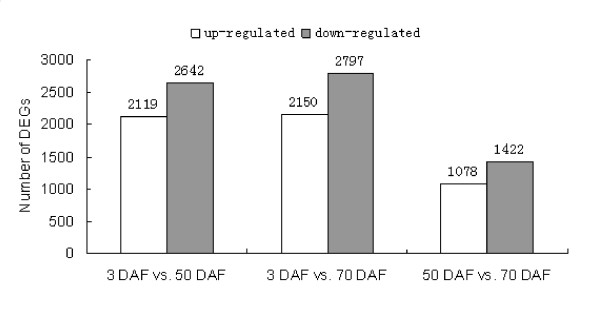
Changes in gene expression profile among the different developmental stages. The number of up-regulated and down-regulated genes between 3 DAF and 50 DAF; 3 DAF and 70 DAF; 50 DAF and 70 DAF are summarized. DEGs: Differentially Expressed Genes.